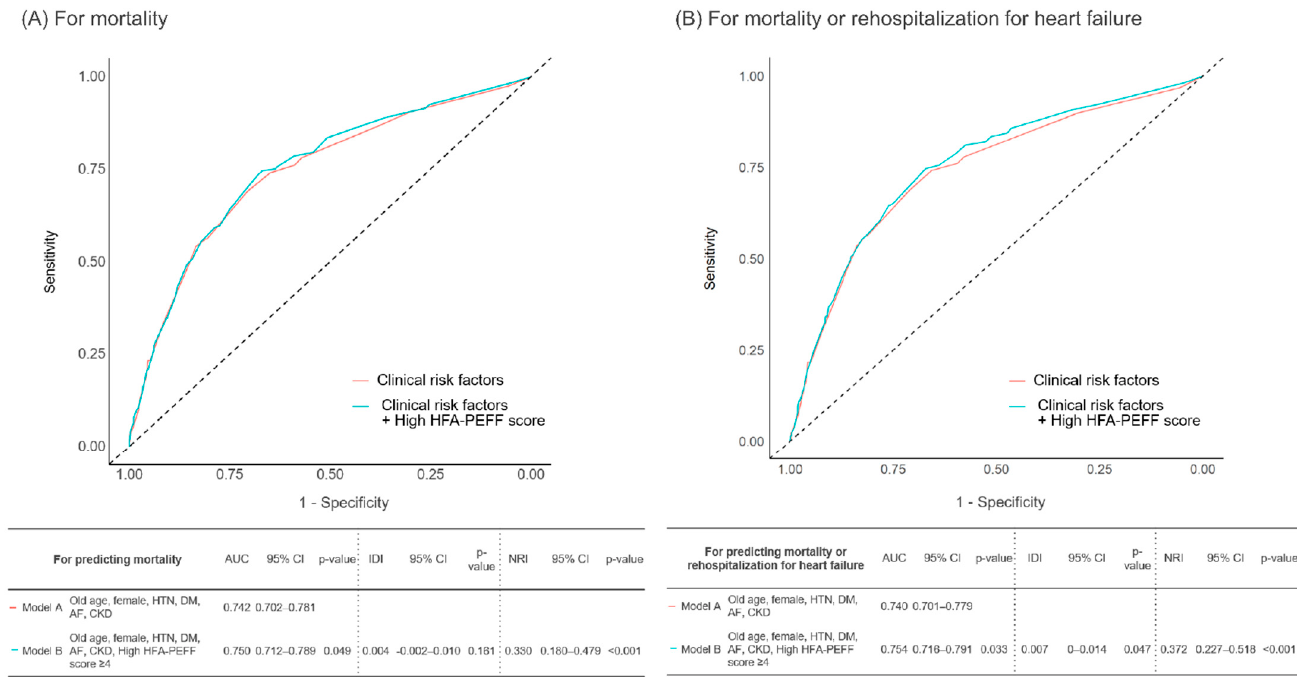
Figure 3. Prognostic impact of HFA-PEFF scores in patients with AMI and an HFA-PEFF score ≥ 2 for predicting ( A ) mortality and ( B ) mortality or rehospitalization for heart failure. Abbreviations: HTN, hypertension; DM, diabetes mellitus; AF, atrial fibrillation; CKD, chronic kidney disease; HFA, heart failure association; AUC, area under the ROC curve; CI, confidence interval; NRI, net reclassification improvement; IDI, integrated discrimination improvement.